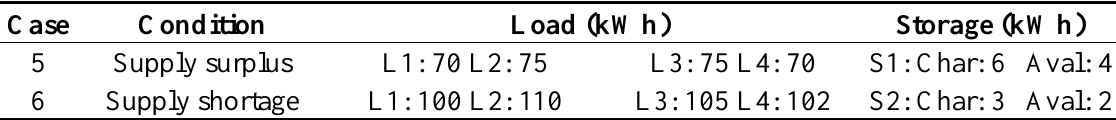
Table 6. Operation condition of Cases